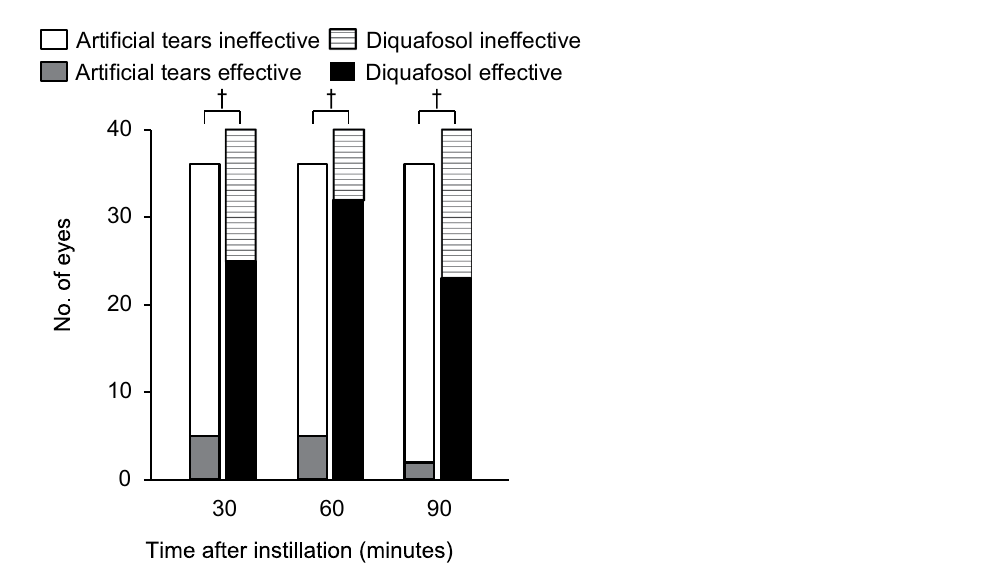
Figure 4. Representative sequential interferometric images of the tear film obtained with the DR-1 α tear interferometer before and after artificial tear or diquafosol administration. The subject was a 48-year-old man with dry eye and meibomian gland dysfunction who received a single drop of artificial tears in his right eye and a single drop of diquafosol in his left eye. Before instillation, both eyes manifested a grayish amorphous interferometric image without a fringe (class 2, evaporative dry eye type), corresponding to an unstable tear film with a thin lipid layer but with sufficient tear fluid. Noninvasive breakup time (NIBUT) increased from 2 s before to 5, 7, and 7 s at 30, 60, and 90 min after diquafosol administration, respectively. The interferometric pattern also changed to a monotonous gray fringe (class 0, normal type) after diquafosol administration, corresponding to a stable tear film with a thicker lipid layer. Artificial tear administration did not alter the tear interferometric pattern, but NIBUT showed a transient increase from 2 s before to 3, 4, and 2 s at 30, 60, and 90 min after administration.